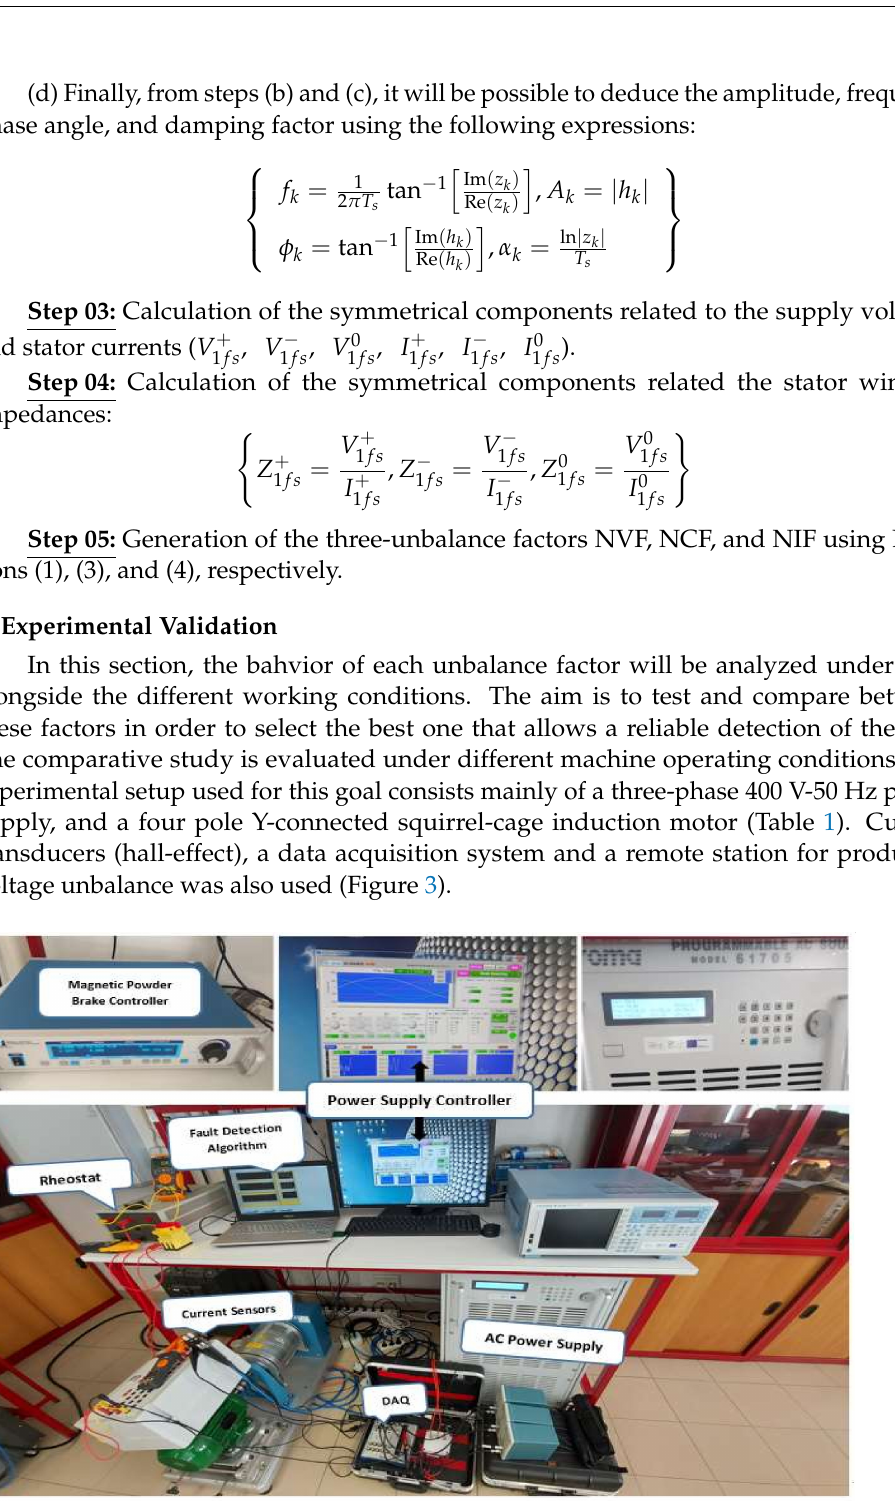
Figure 3. Experimental